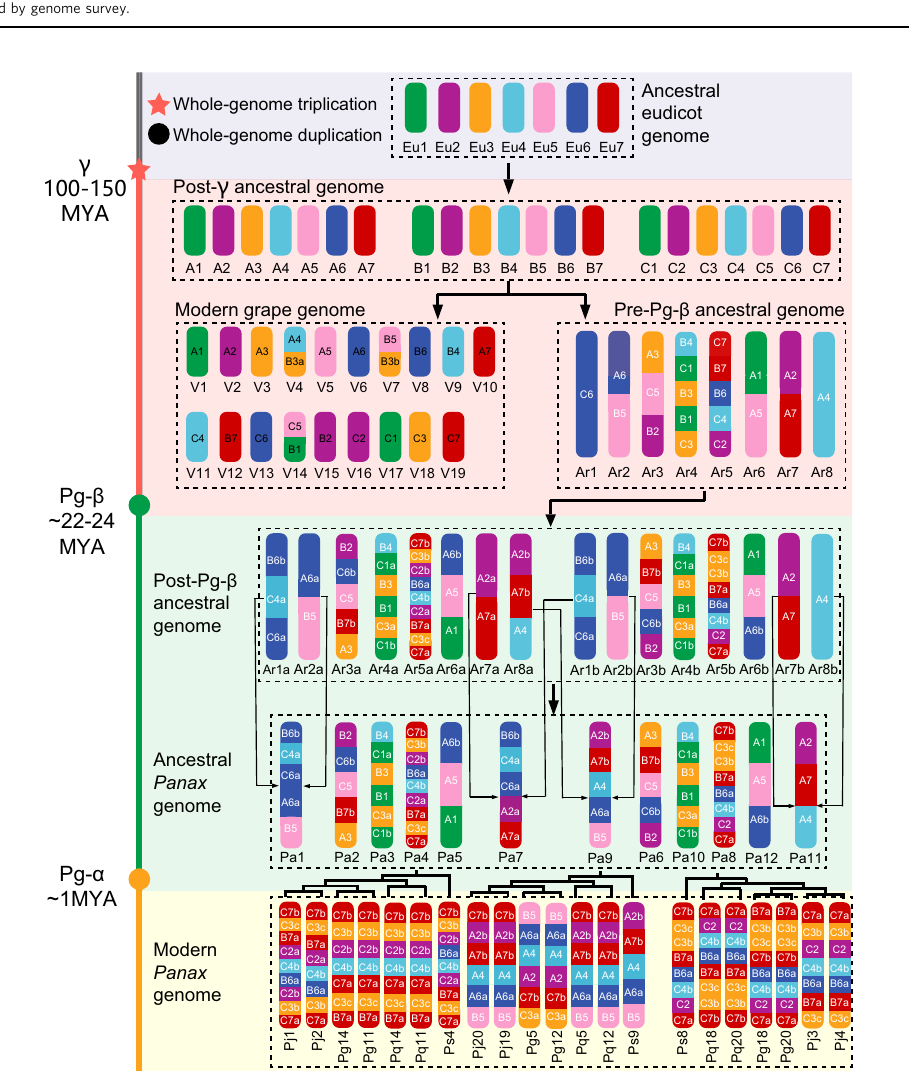
Fig. 1 Evolutionary rearrangements of the ancestral core-eudicot genome to generate the genome of extant ginseng species. The ancestral core-eudicot genome is hypothesized to contain seven chromosomes (Eu1 – Eu7) marked with seven different colors. The post- γ ancestral genome consists of three chromosomal compartments (A1 – A7, B1 – B7 and C1 – C7) which were reunited into the same nucleus some 100 – 150 million years ago (MYA). The extant grape genome (V1 – V19) has evolved from the post- γ karyotype through one chromosomal fi ssion and two fusions. In parallel, the post- γ ancestral genome was structured into a pre-Pg- β karyotype with eight chromosomes (Ar1 – Ar8). The pre-Pg- β karyotype was doubled about 22 – 24 MYA (Ar1a – Ar8a